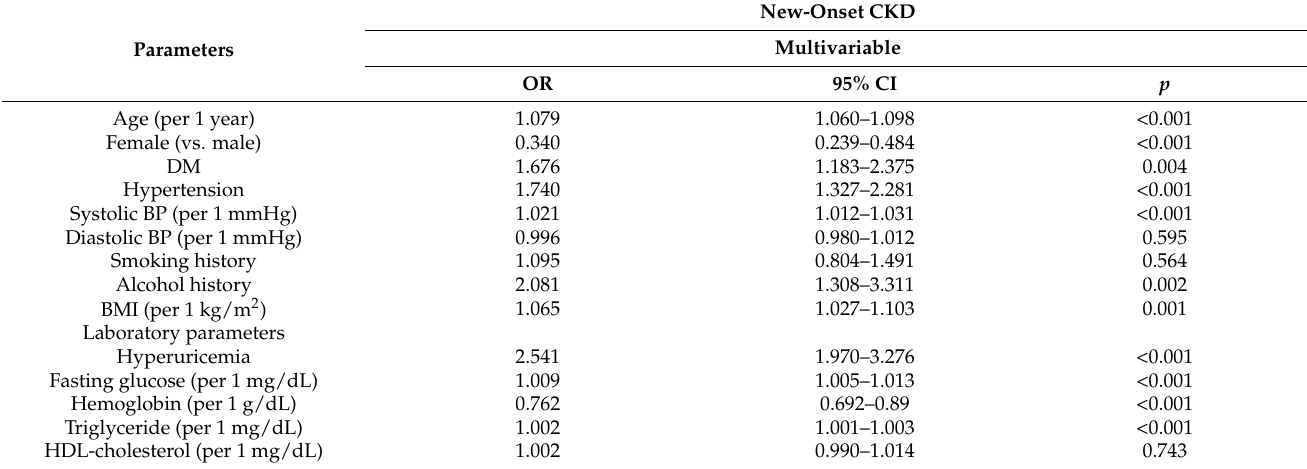
Table 2. Determinants for new-onset CKD using multivariable logistic regression